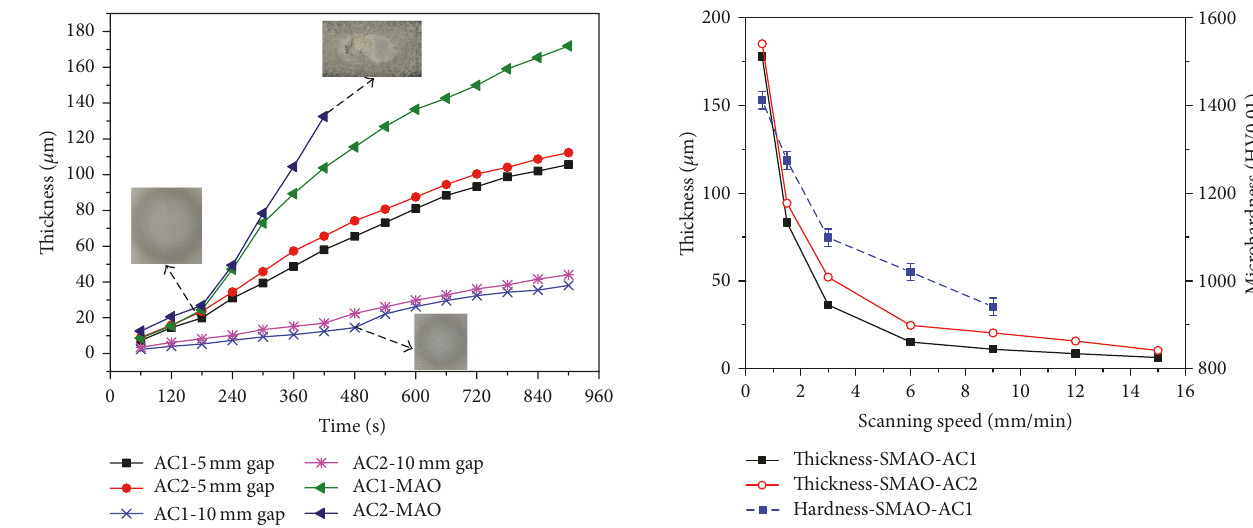
Figure 9: SMAO and MAO oxide layer thickness as a function of total treatment time using a Na 2 SiO 3 /NaOH electrolyte solution.